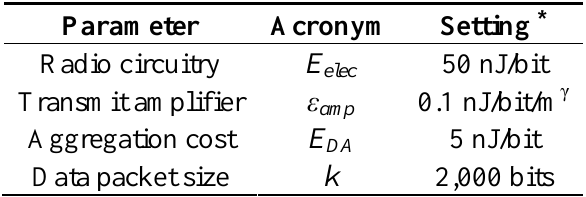
Table 1. Parameter settings used in the